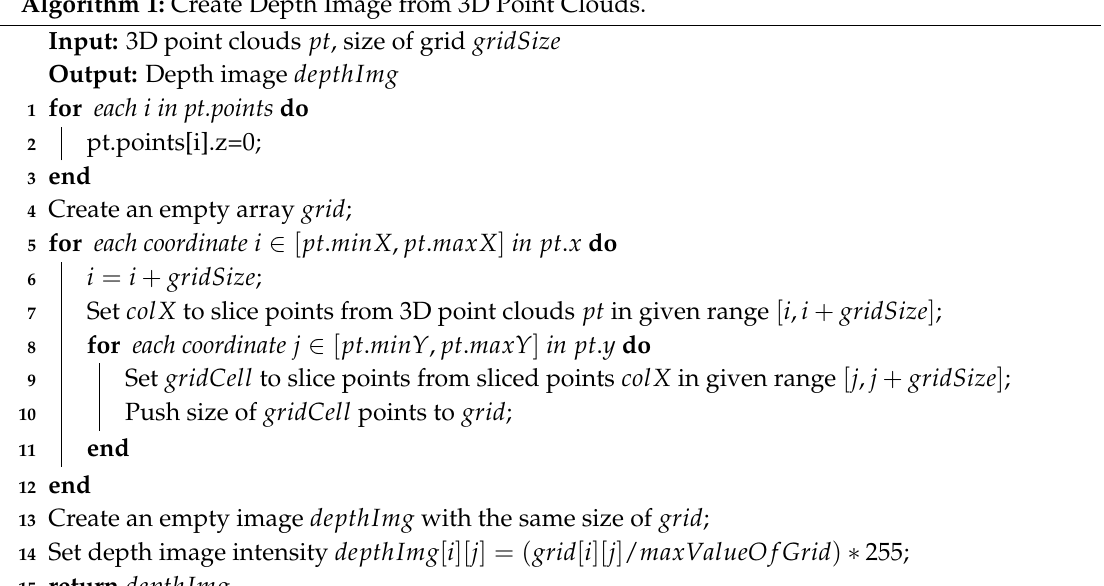
Algorithm 1: Create Depth Image from 3D Point